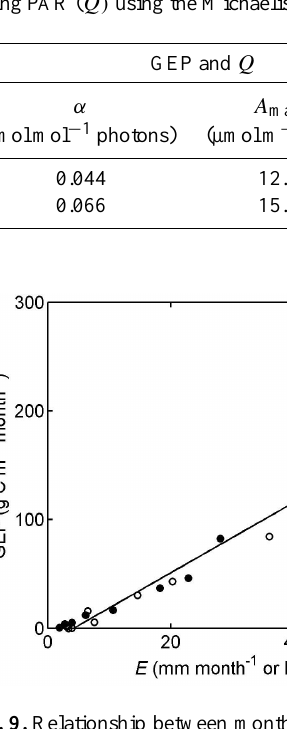
Fig. 9. Relationship between monthly mean gross ecosystem pho- tosynthesis (GEP) and evapotranspiration ( E ) at MPB-09 in 2010 and 2011. The line and equation is the linear regression relationship for all